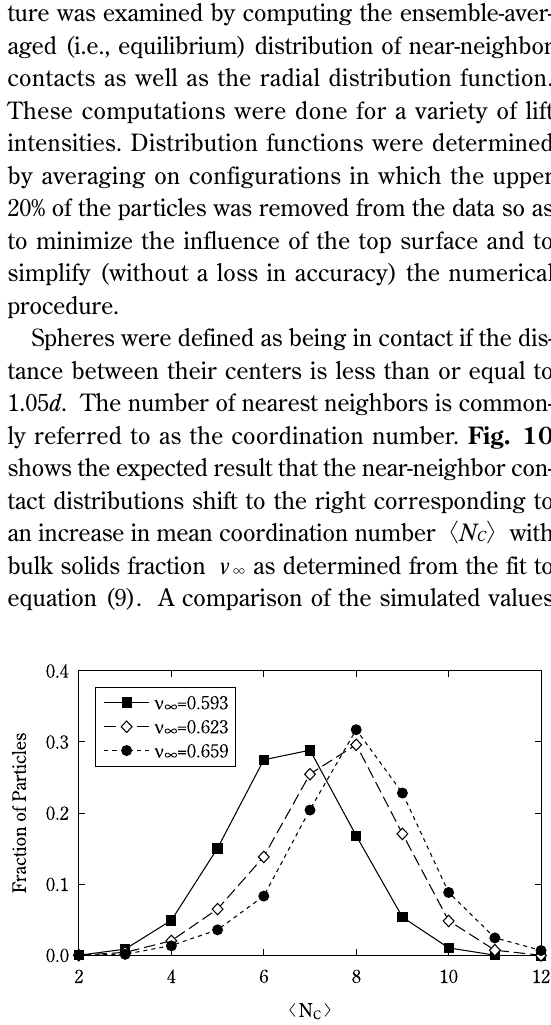
Fig. 10 Mean coordination number (i.e., fraction of particles with mean number of nearest contacts 〈 N C 〉 ) for equilibrium bulk sol- ids fraction values ν ∞ ＝ 0.593( * ); ν ∞ ＝ 0.623, ( ♢ ), and ν ∞ ＝ 0.659( ♦ ). As expected, systems which are more tightly packed have, on the average, more contacts per